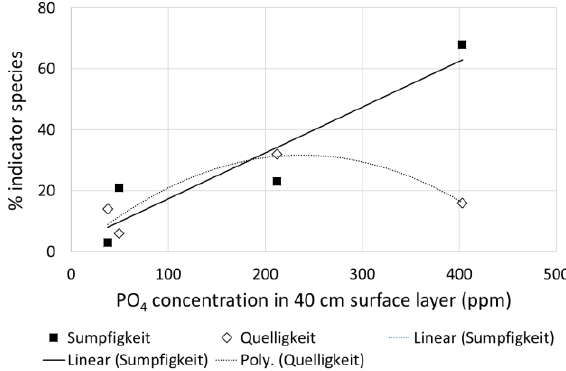
Figure 6. Indicators of mire margin influence ( Sumpfigkeit meaning surface water influence and Quelligkeit groundwater influence) (y-axis) in relation to measured PO concentrations (x-axis) in 4 a 40 cm layer of surface peat and sediment. Trend lines are shown but the correlations are not statistically significant due to the small number of occurrences.